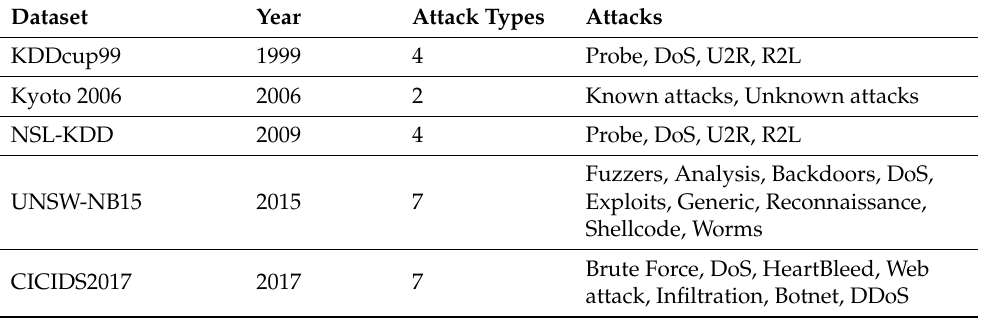
Table 3. Datasets